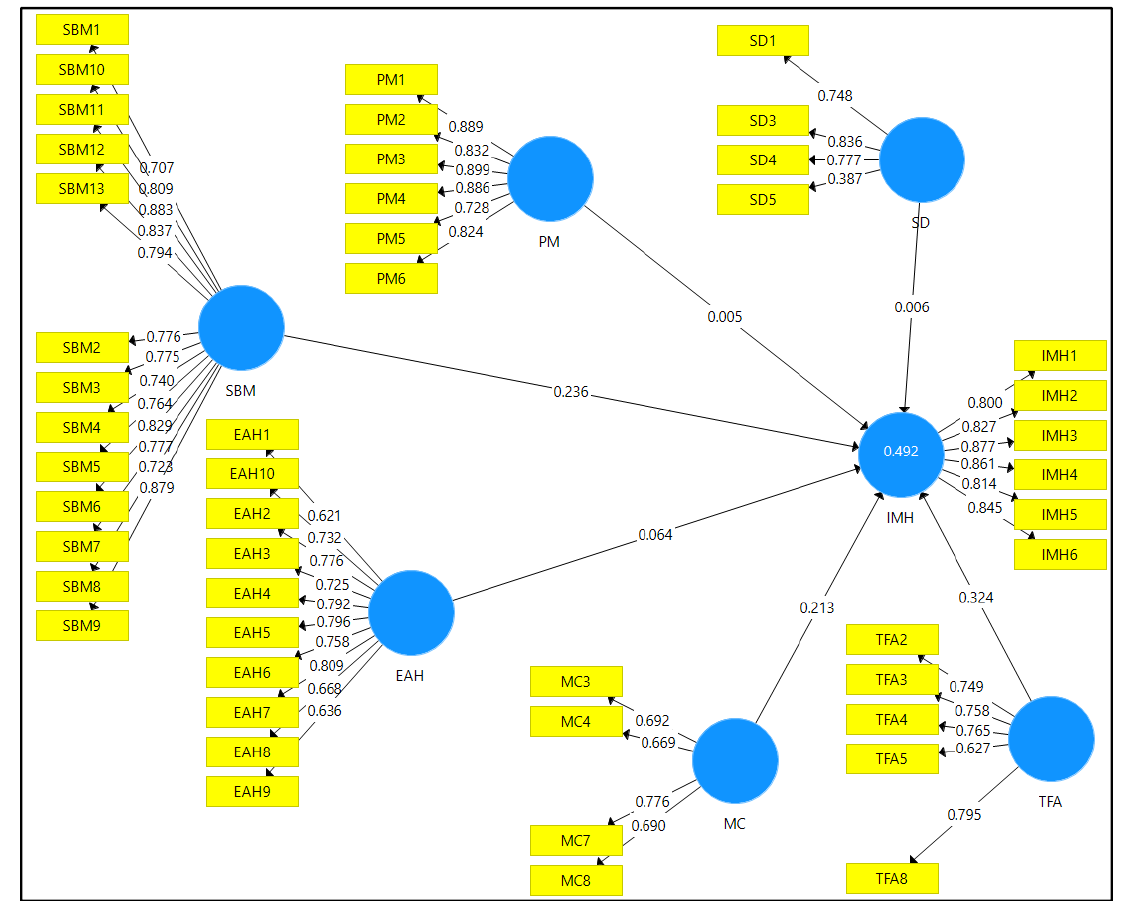
Figure 2. Measurement model.